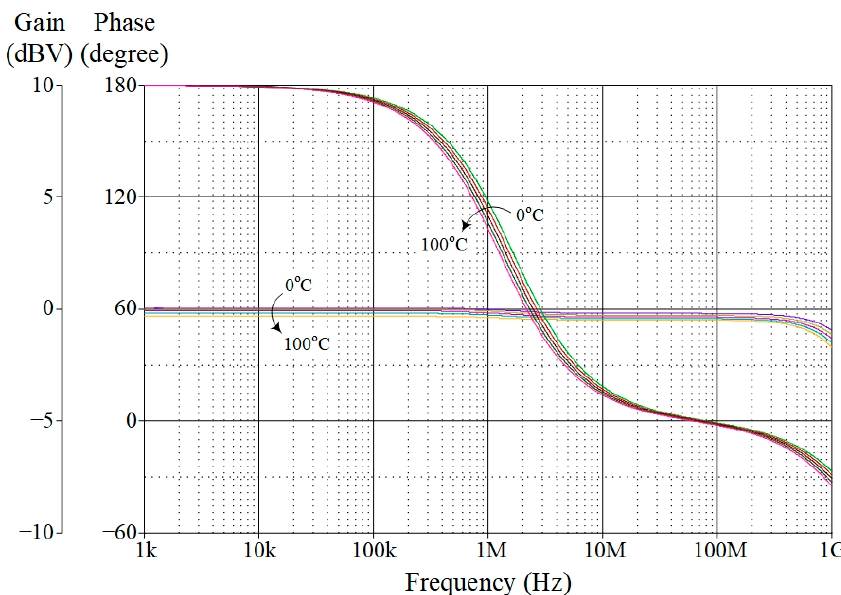
Figure 10. Simulated frequency characteristics of the proposed VM AP filter at temperatures of 0 °C, 25 °C, 50 °C, 75 °C, and 100 °C. Table 5. Gain and phase values of the proposed VM AP filter at f p for different temperatures.